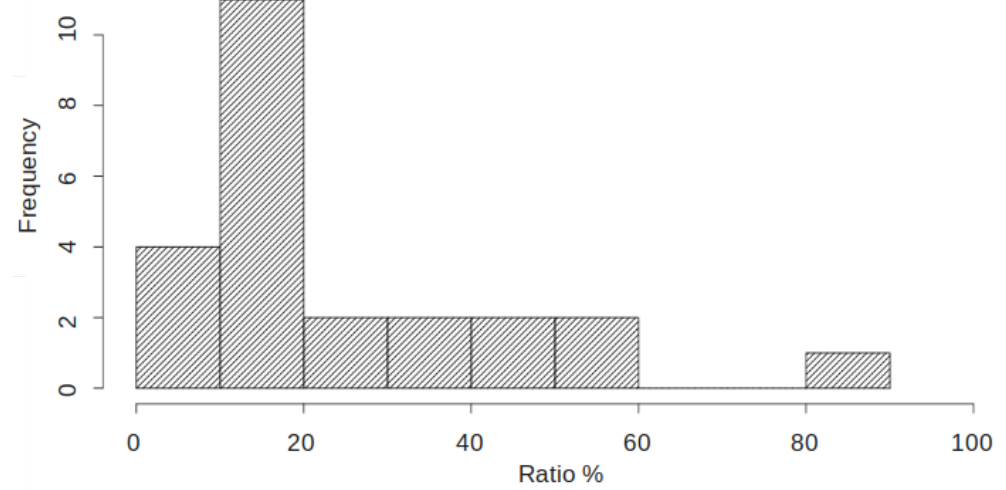
Figure 4. Histogram of the percentage of the Hard Cap per ICO to be reached to consider the ICO as a success.